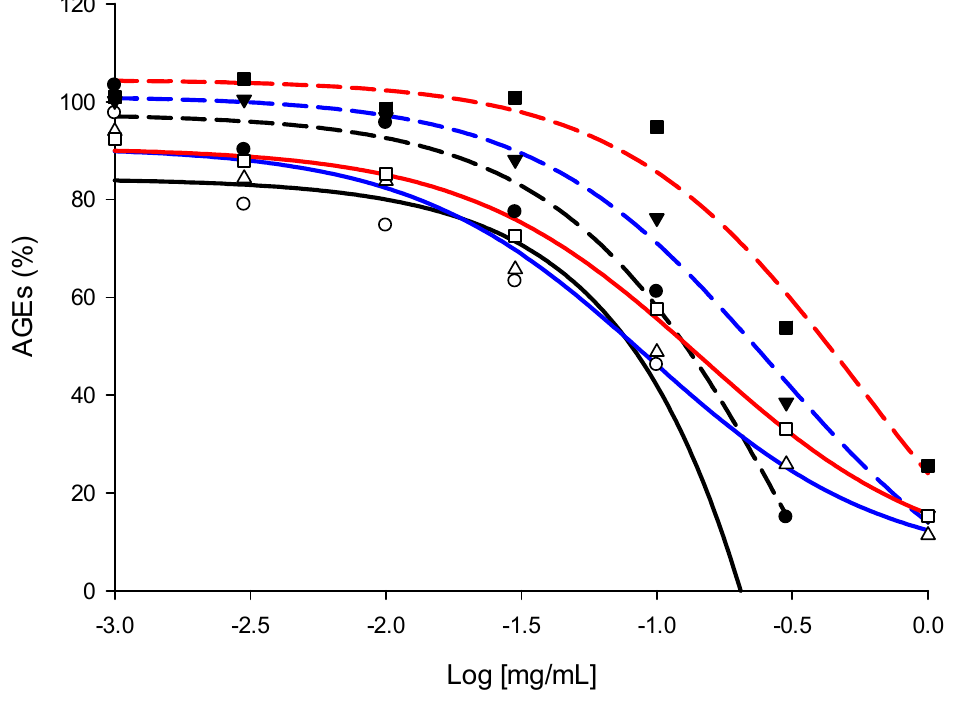
Figure 6. Dose-effect curves for vesperlysines-like AGE (dotted) and pentosidine-like AGE (bold) formation in the presence of quinquina EtOH extract (Black), sophora EtOH extract (Blue) or sophora aqueous extract